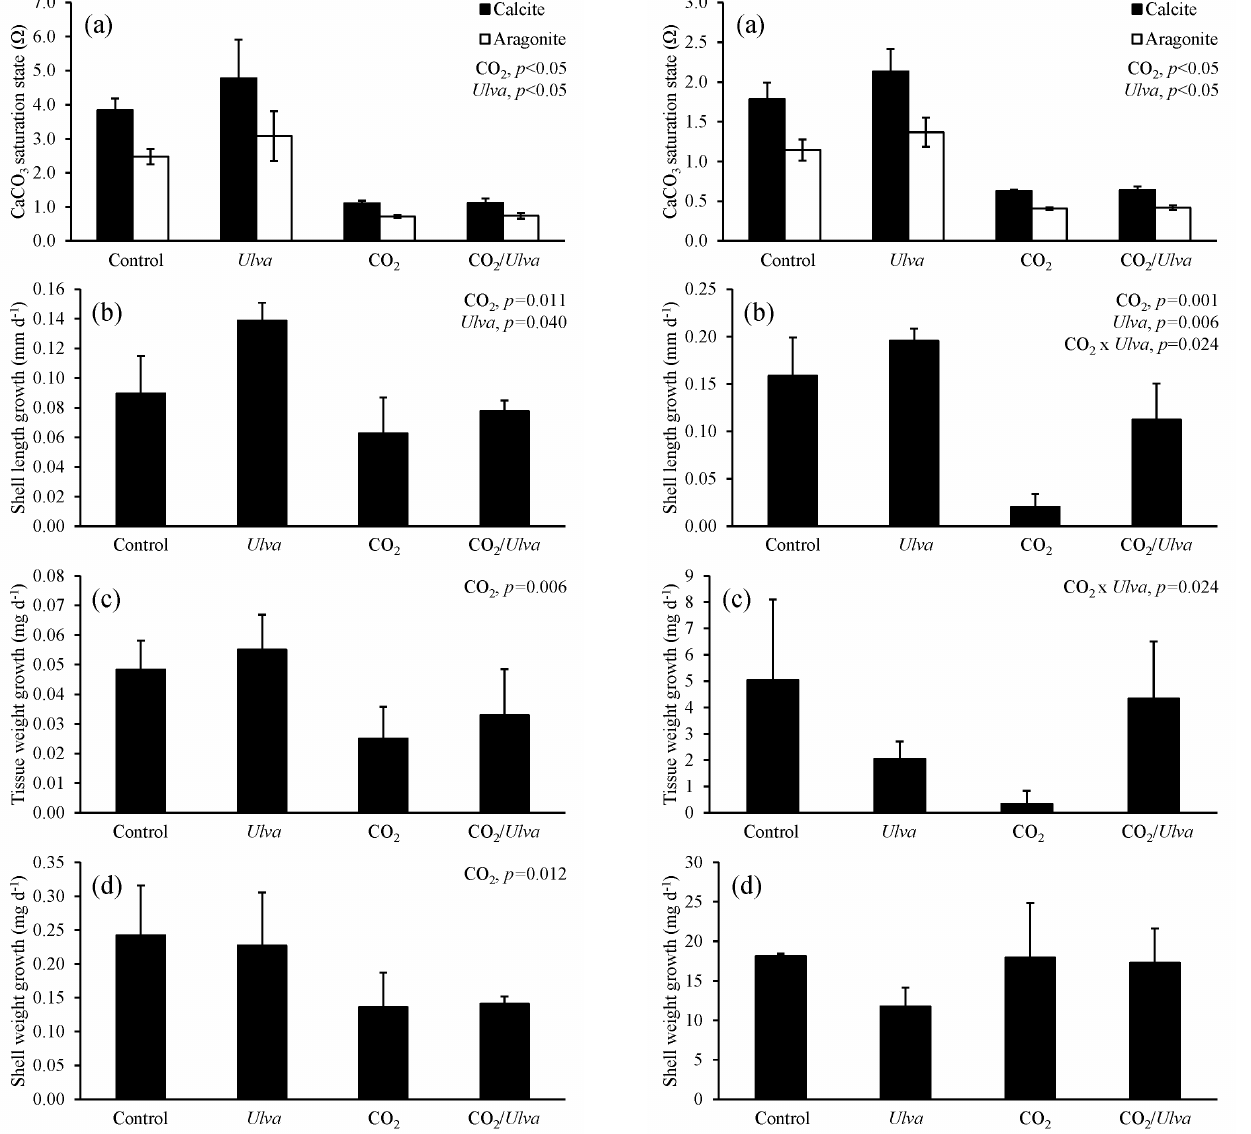
Figure 3. Experiment with small juvenile Crassostrea virginica exposed to ambient and elevated concentrations of CO 2 with and without the presence of Ulva . (a) (cid:127) calcite and (cid:127) aragonite ; growth was based on (b) shell length, (c) tissue weight, and (d) shell weight. Columns represent means ± standard deviation. Significant main treatment effects (CO 2 and Ulva ) appear at the top right of each panel.